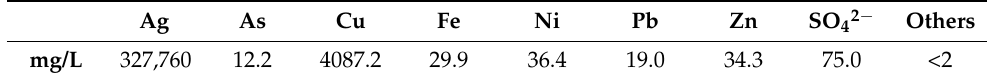
Table 5. Ag + enriched solution